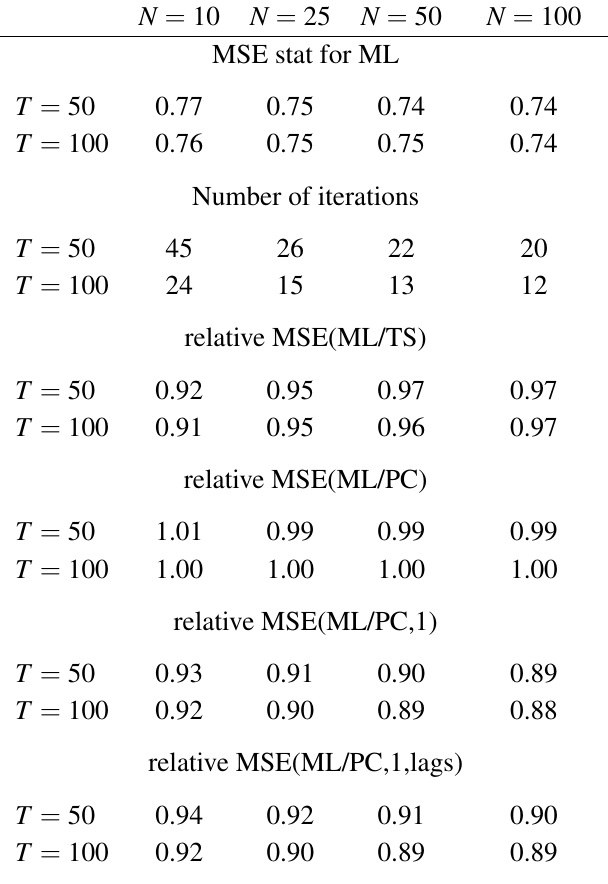
Table 8: Extended experiment. Relative MSE